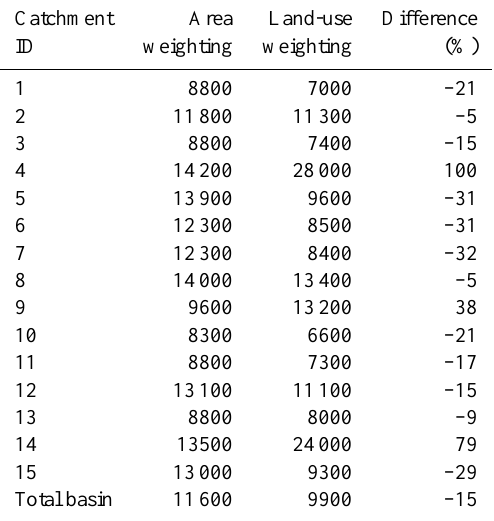
Table 2. Comparison of NANI and relative error in the 15 catch- ments (unit: kgNkm − 2 yr − 1 ) . Catchments with a higher proportion of farmland and resident land have a relatively larger change.